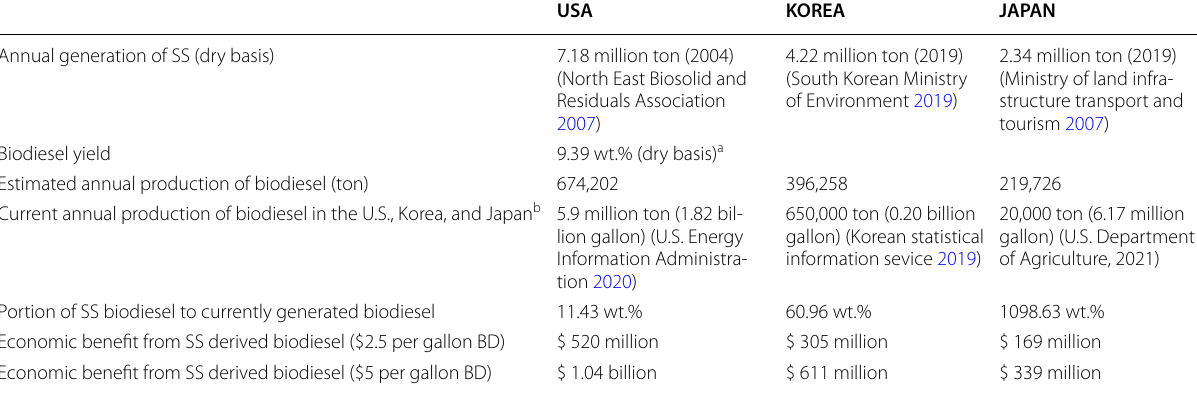
Table 4 Economic assessment of biodiesel production from SS through thermally induced transesterification reactions